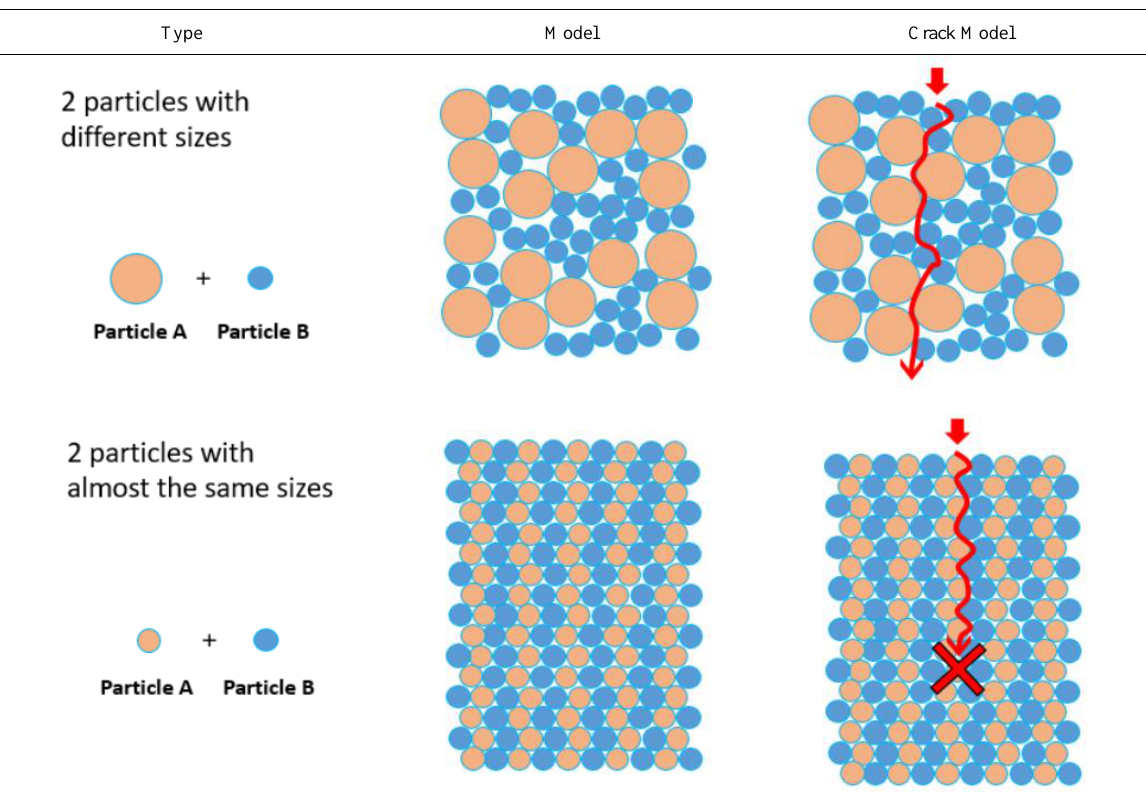
Table 5. The ilustration of dual components in the mechanical properties. Table was adopted from reference